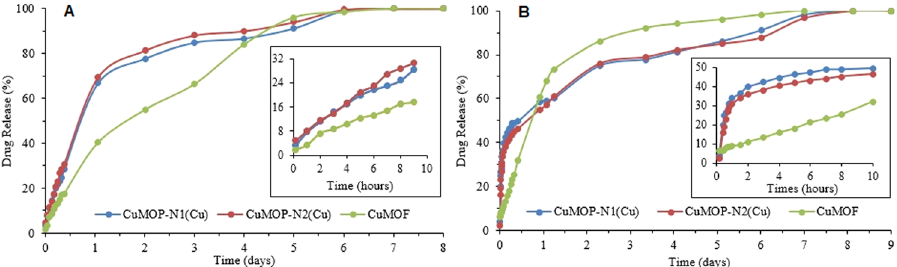
Figure 6. Release profiles of the drugs ( A ) 5-flourouracil (5-FU) and ( B ) caffeine (CAF) from the drug-loaded materials. Loading contents for CuMOP-N1(Cu): 32.21% (5-FU) and 39.74% (CAF); CuMOP-N2(Cu): 32.37% (5-FU) and 35.58% (CAF); Cu-MOF 19.49 (5-FU) and 23.76%